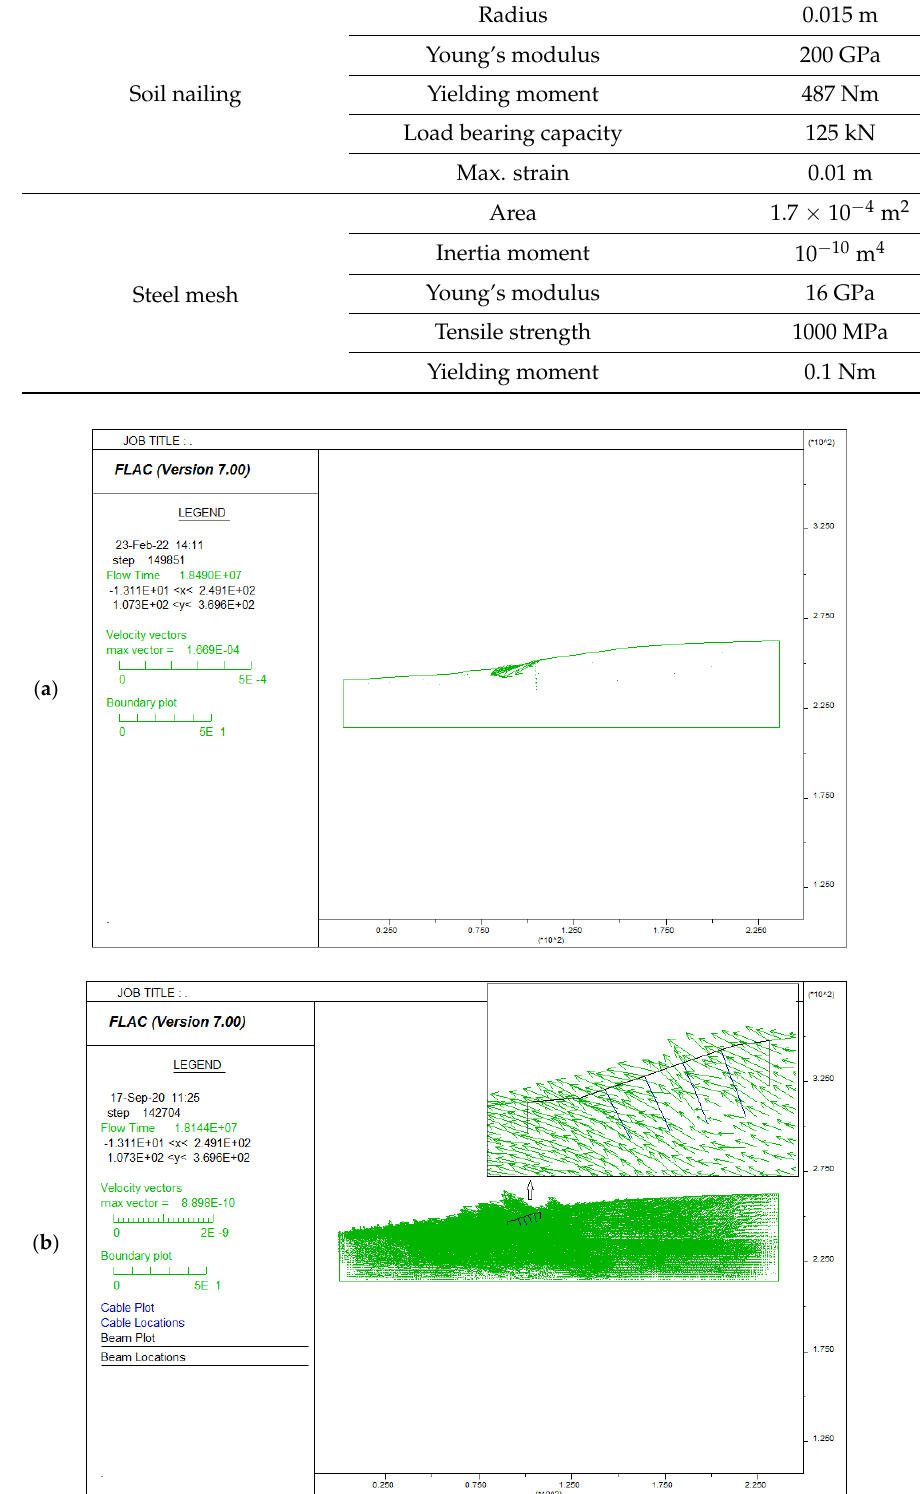
Figure 10. Maps of velocity vectors in Variation IV as an example: ( a ) without any slope protection, ( b ) with slope reinforcement using nailing and steel mesh.